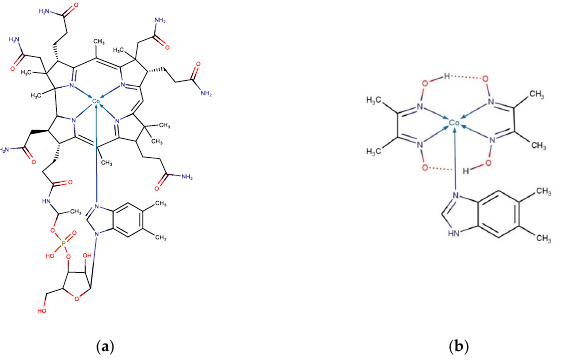
Scheme 1. Schematic representations of compounds ( a ) cobalamin and ( b ) 5,6-dimethylbenzimid- azole-bis(dimethylglyoximate)cobalt(II) (cob[II]aloxime or Co II